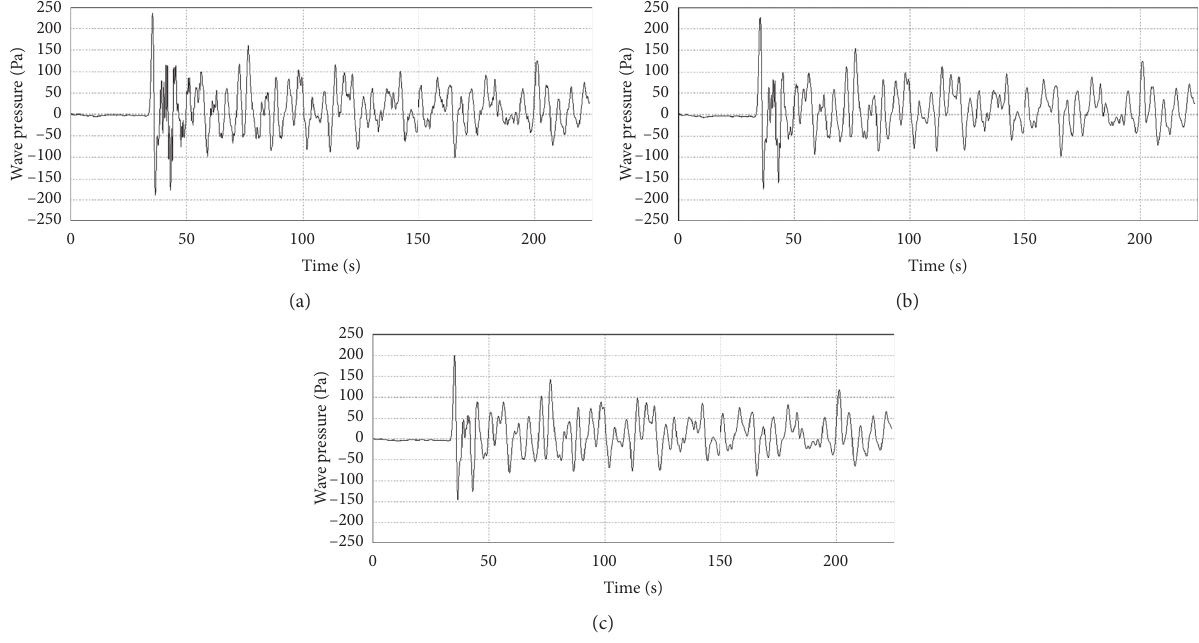
Figure 6: Seventeen wave pressure changes at each measuring point (20 ° , 88 cm, 1 × 1.5 × 0.4m 3 ). (a) Upper measuring point. (b) Middle measuring point. (c) Lower measuring